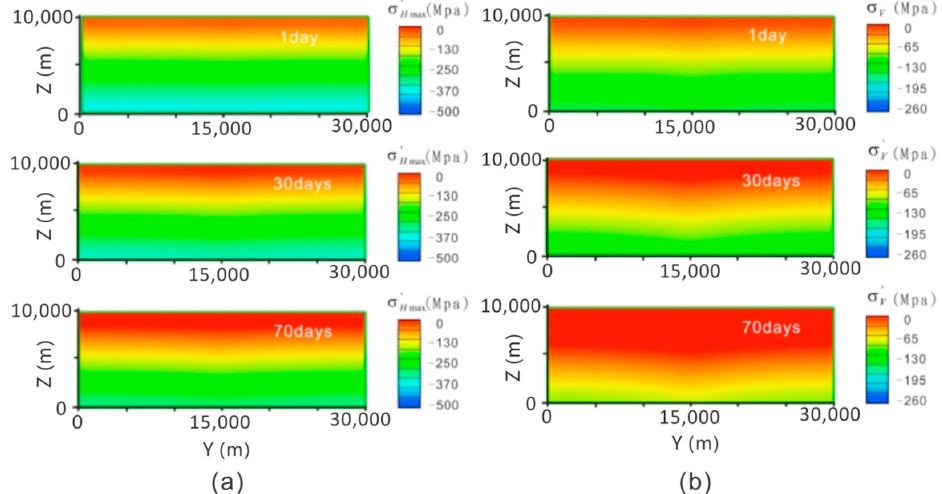
Figure 6. The distribution of effective stress ( a ) in the X-direction σ (cid:48) H max ; ( b ) in the Z-direction σ (cid:48) v during the fluid intrusion.